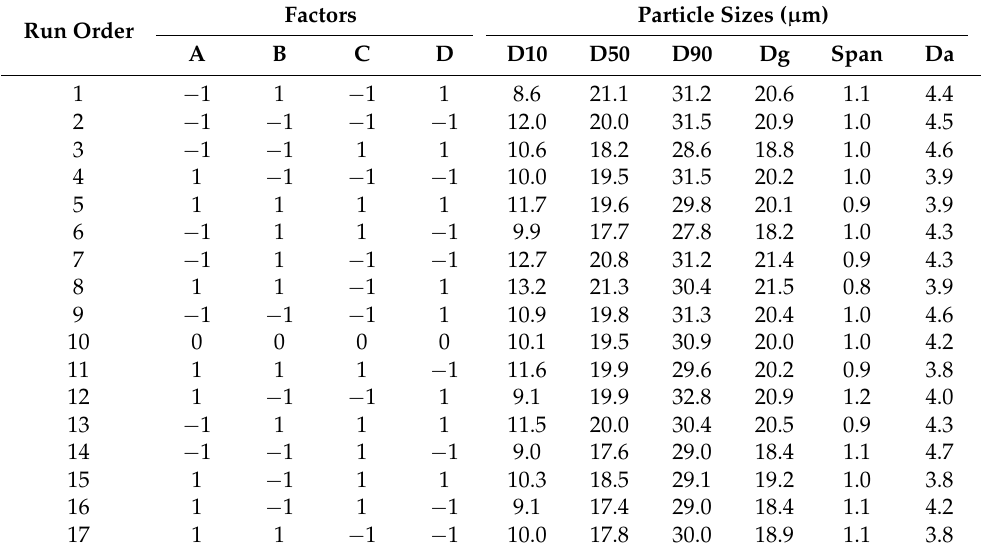
Table 1. Experiments and results of the Minitab